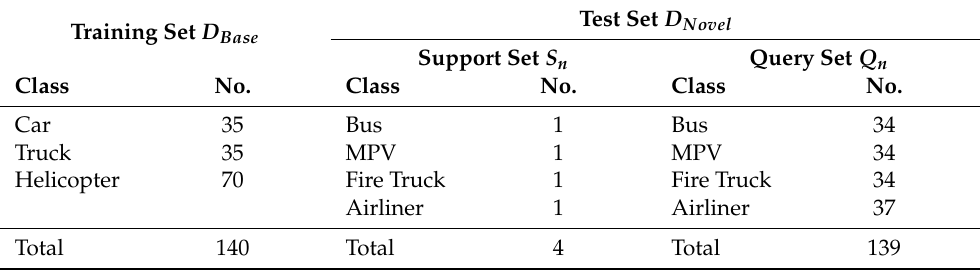
Table 4. The number of images in the training, support and query sets of the VA